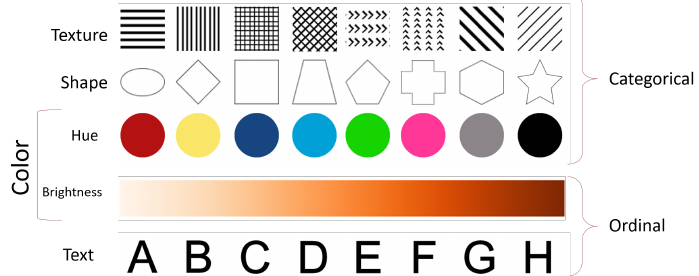
Figure 2. The values used in this study referred to the visual variables (layers): texture, shape, color hue, color brightness and text .